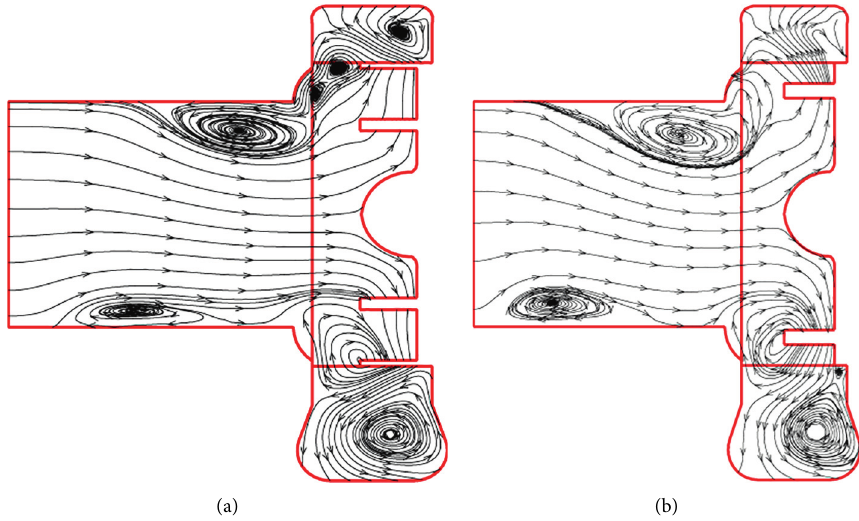
Figure 9: Streamline in a middle section: (a) prototype model; (b) optimization model.